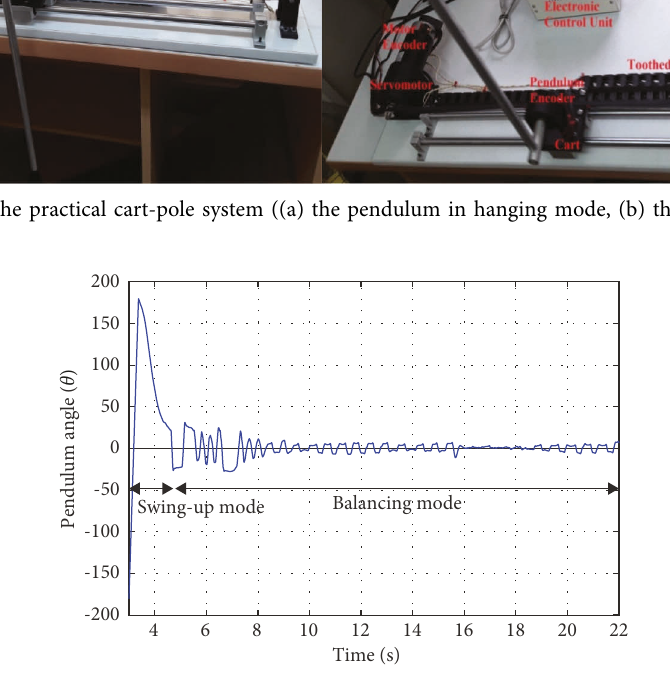
Figure 17: Pole angle based on the suggested fuzzy-PID controller.